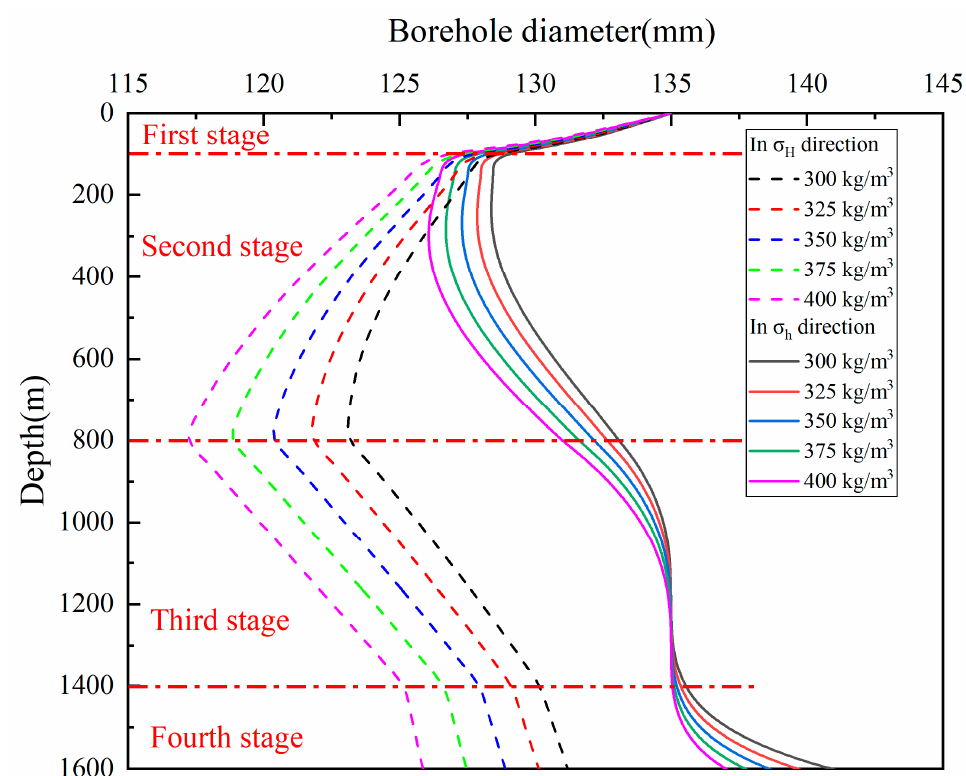
Figure 9. Sensitivity analysis of changes in borehole diameter with surface snow density in one year.